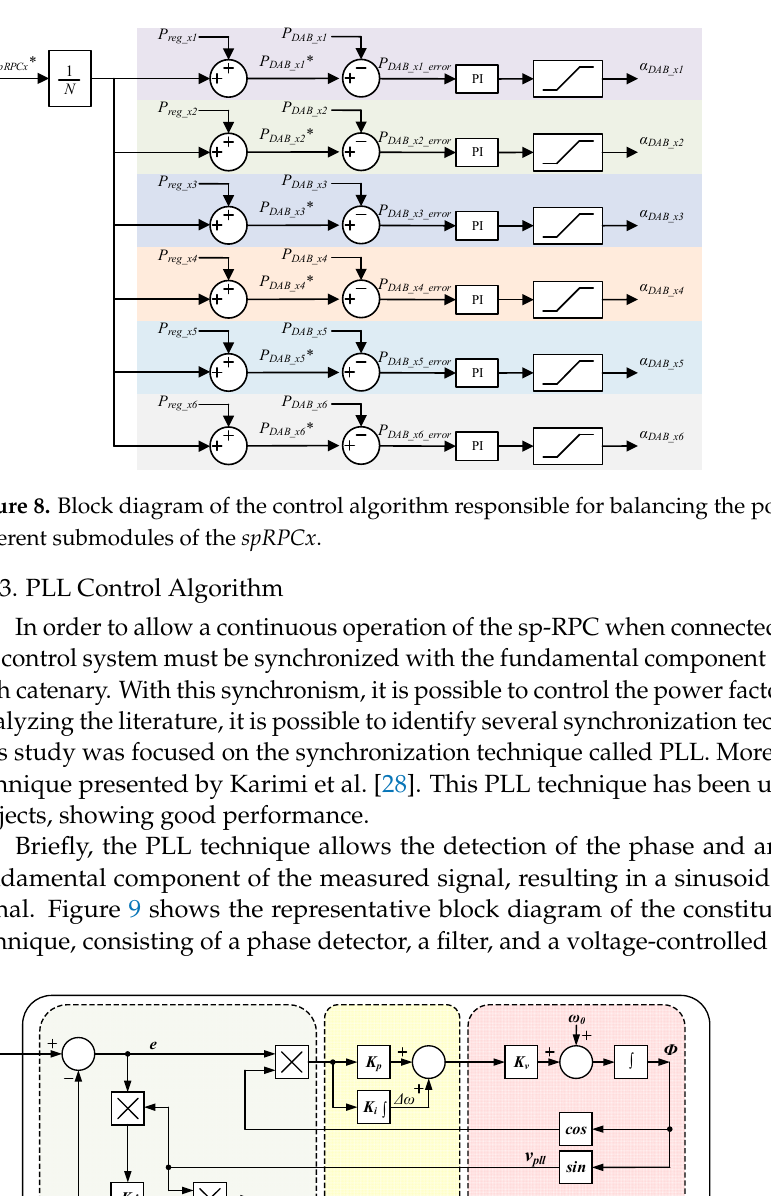
Figure 7. Block diagram of the control algorithm responsible for regulating the di ff erent dc-link voltages on the spRPCx .